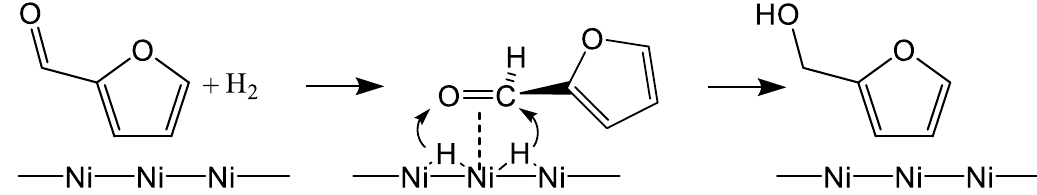
Figure 2. Proposed reaction mechanism for the hydrogenation of furfural over Ni/SiO 2 (Reproduced from [68] with the permission of John Wiley and Sons, 2012).